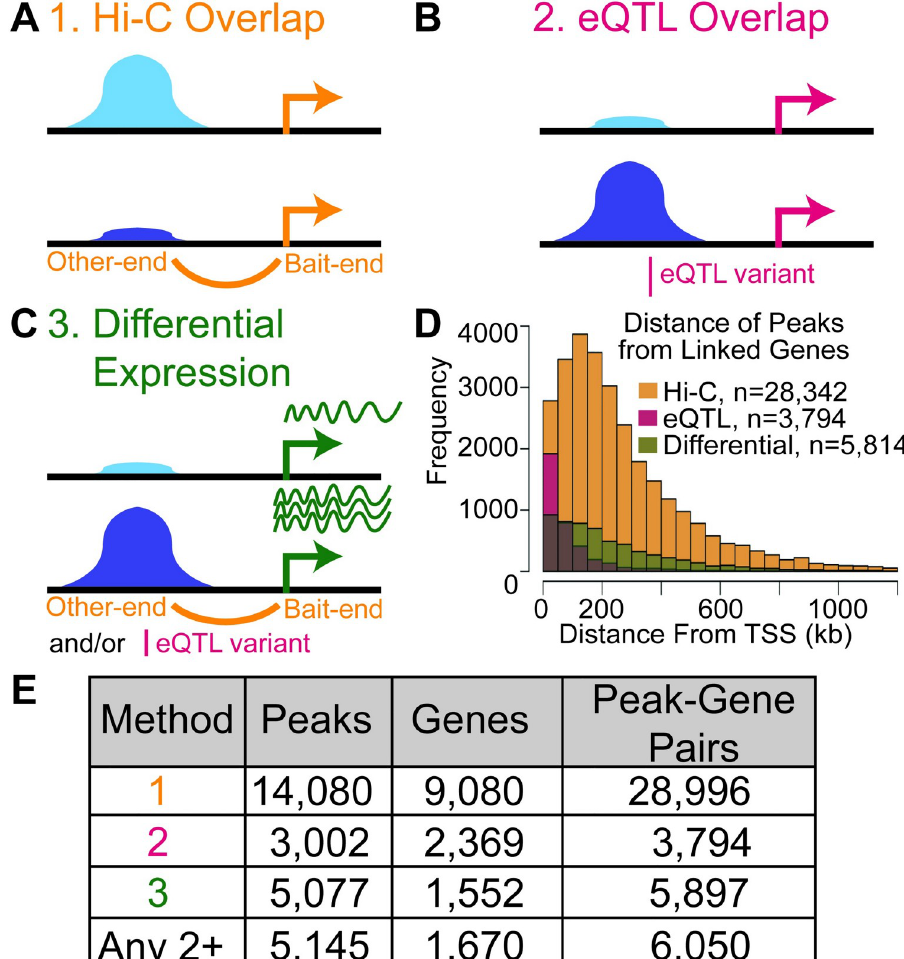
Fig 2. Linking context-dependent chromatin accessibility to candidate genes. (A-C) Schematic of three approaches to link peaks to genes. Day 0 (light blue) and day 14 (dark blue) context-dependent peaks are represented. (A) Context- dependent peaks that overlap elements connected to gene promoters using adipocyte promoter capture Hi-C (orange). (B) Context-dependent peaks that overlap adipose gene eQTL variants (r 2 > .8 with lead, red). (C) Context-dependent peaks linked to a gene through Hi-C or eQTL for which the linked gene was also differentially expressed between any timepoints (green). (D) Histogram of distances from edges of peaks to the transcription start site of a linked gene within 1.2 Mb. Values in S12 Table. (E) Numbers of context-dependent peaks linked to genes by each method and by two or more methods. Values summarize full results in S12 Table.